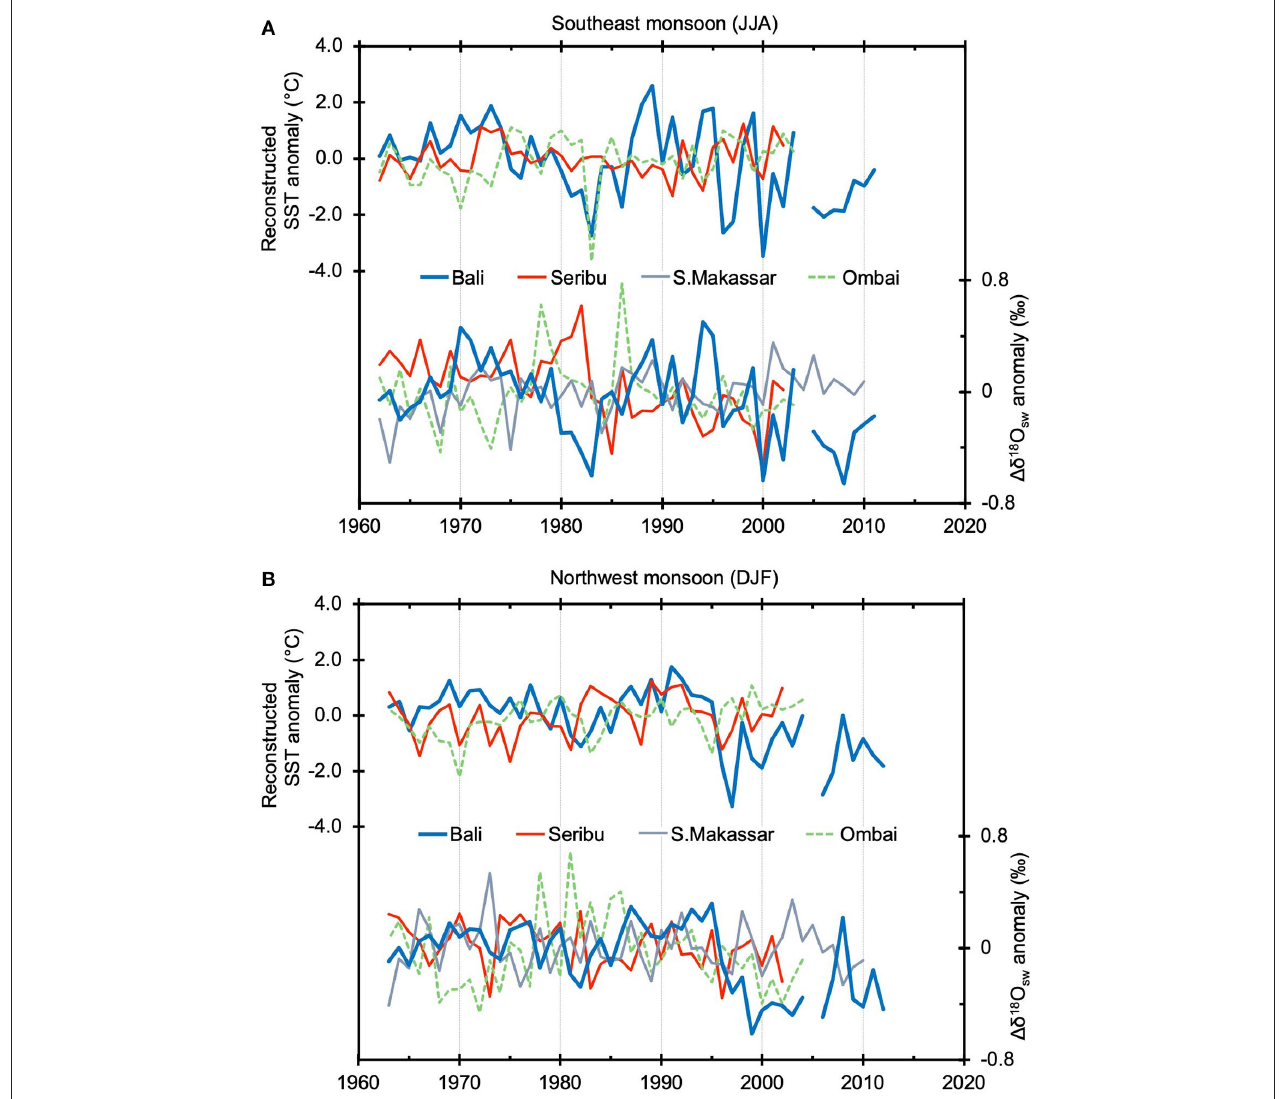
FIGURE 10 | Time series of anomalies of reconstructed SST and 1 δ 18 O sw in the Bali (blue), Seribu (red), southern Makassar Strait (gray), and Ombai Strait (green) records for (A) the southeast monsoon (JJA) and (B) the northwest monsoon